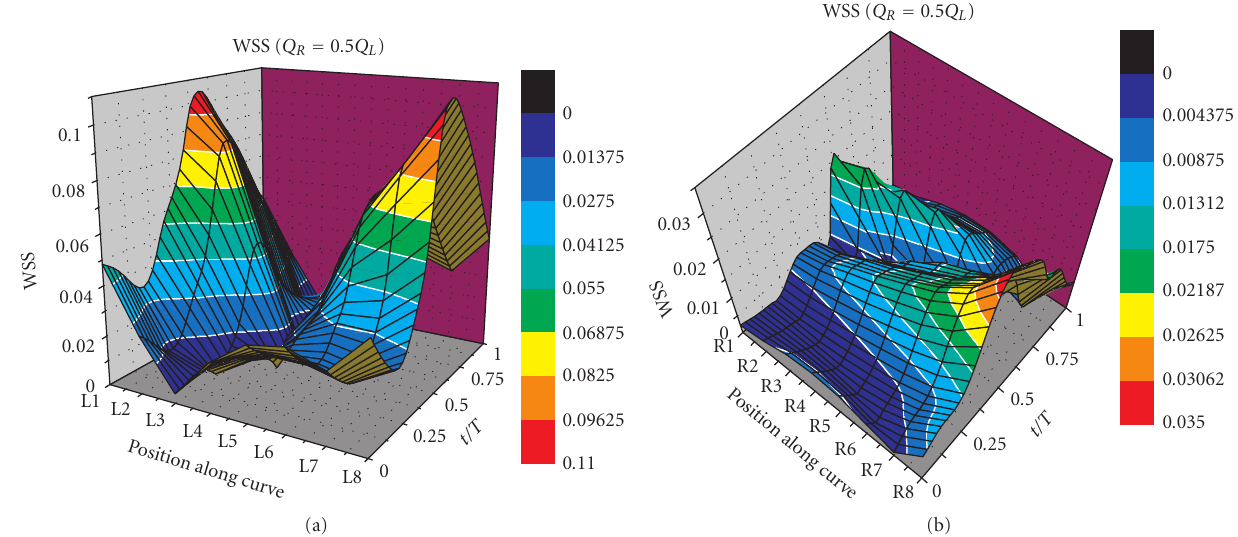
Figure 9: WSS versus position and time for Q R = 0 . 5 Q L on (a) the left and (b) the right bifurcation regions.